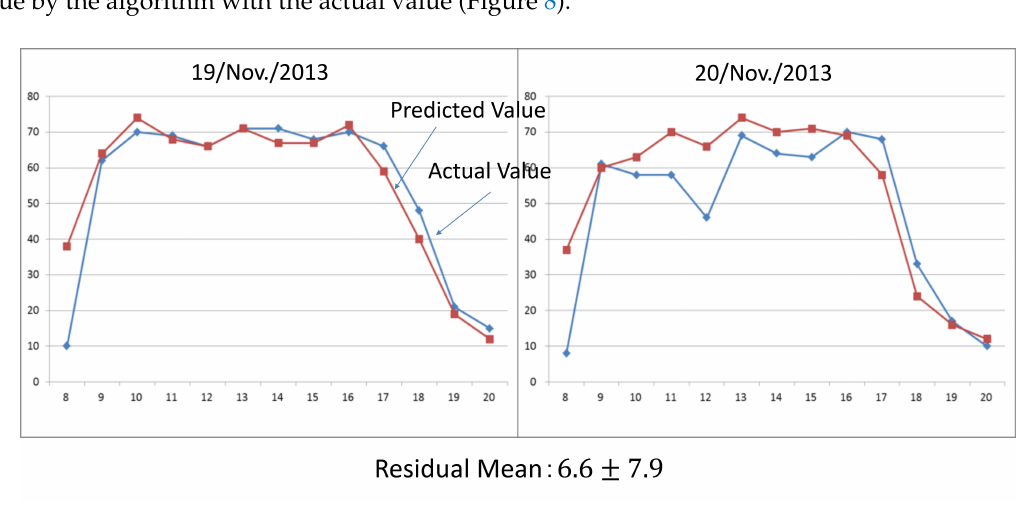
Figure 8. Example of algorithm validation (number of persons).